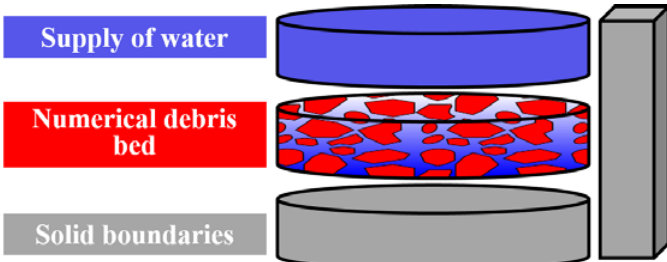
Figure 1: Scheme of the benchmark configuration for the cylindrical debris